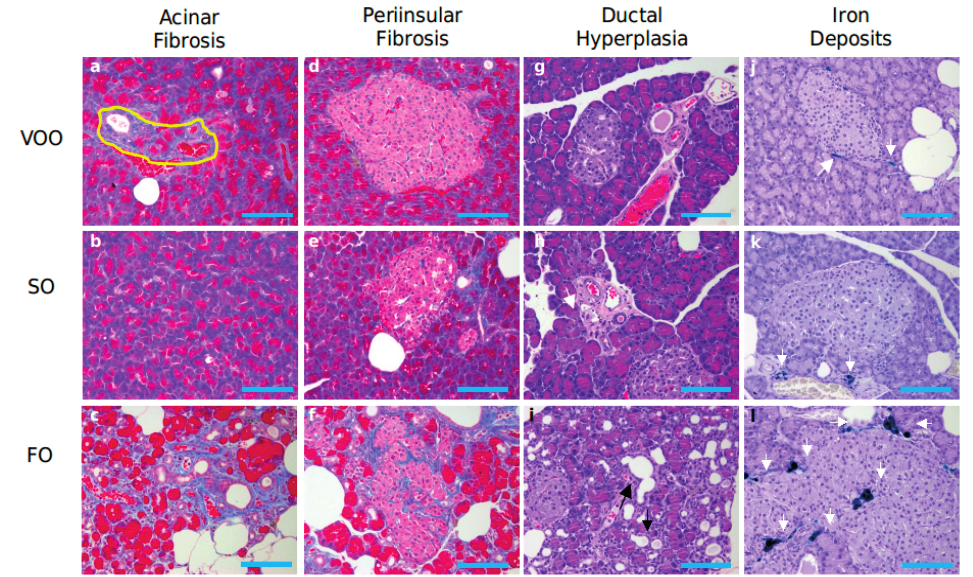
Figure 2. Histological sections of pancreas from rats fed on different dietary fat sources supplemented with coenzyme Q: virgin olive (VOO), sunflower (SO) and fish oil (FO) after Trichrome Masson ( a – f ), Hematoxilin and eosin ( g – i ) and Perls staining ( j – l ) for assessment of acinar and peri-insular fibrosis, ductal hyperplasia and iron deposits, respectively. ( a ) Minimal acinar fibrosis (indicated by a yellow circle); ( b ) Normal pancreatic acini; ( c ) Acinar fibrosis grade 3; ( d , e ) Absence of peri-insular fibrosis; ( f ) Moderate fibrosis; ( g , h ) Absence of ductular hyperplasia; ( i ) Ductular hyperplasia (indicated by black arrows); ( j , k ) Very low number of macrophages stained for hemosiderin (grade 1) with peri-insular distribution (indicated by white arrows); ( l ) High number of macrophages stained for hemosiderin (grade 3–4), (hemosiderin deposited are indicated by white arrows). Blue bar = 100 μ